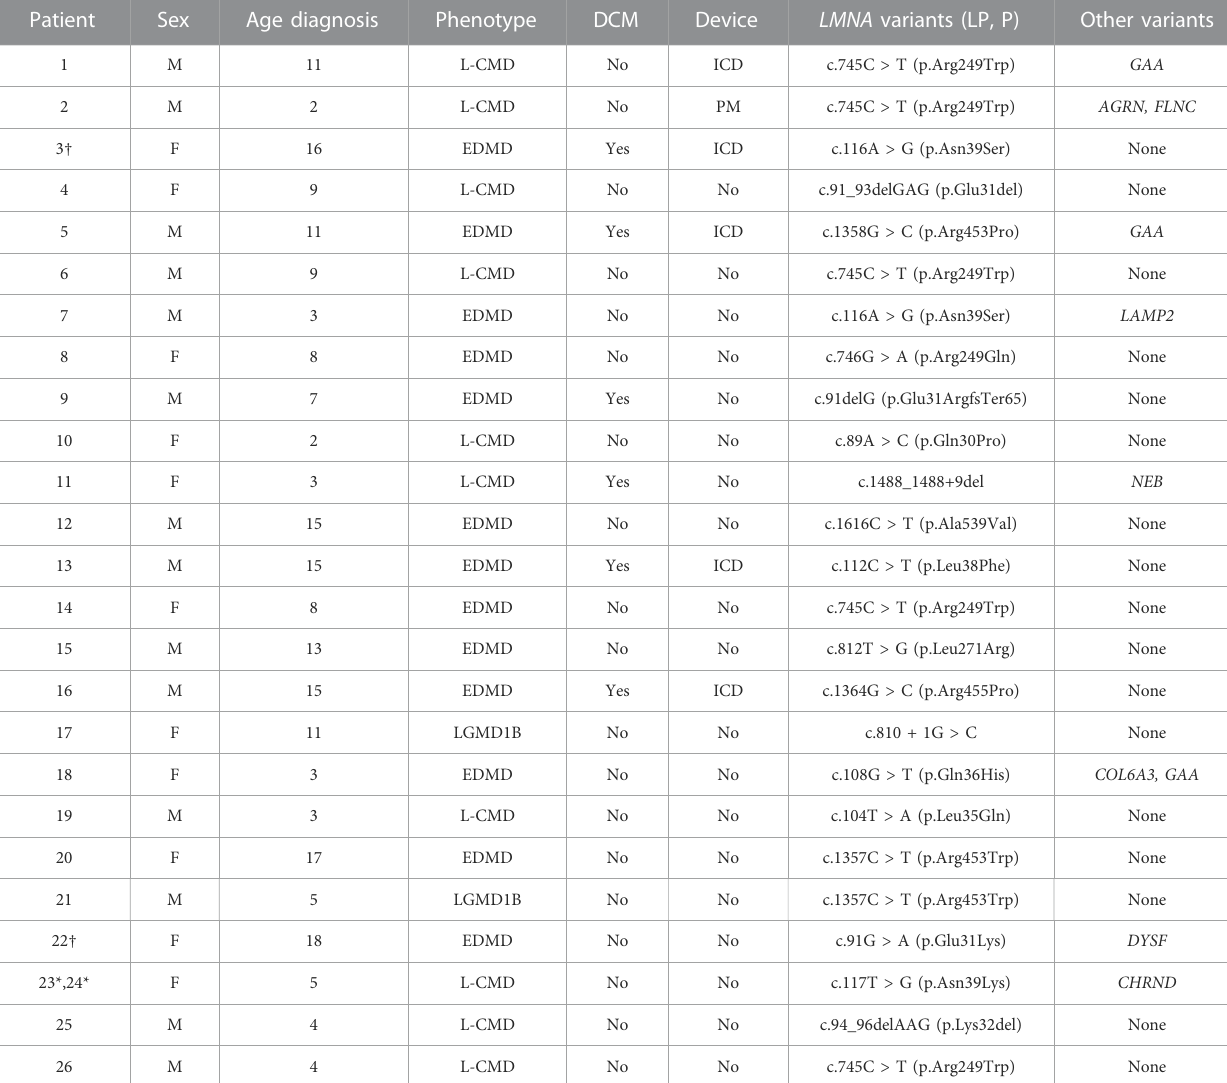
TABLE 1 LMNA -related muscular dystrophy patients, major cardiac end points and rare LMNA variants.